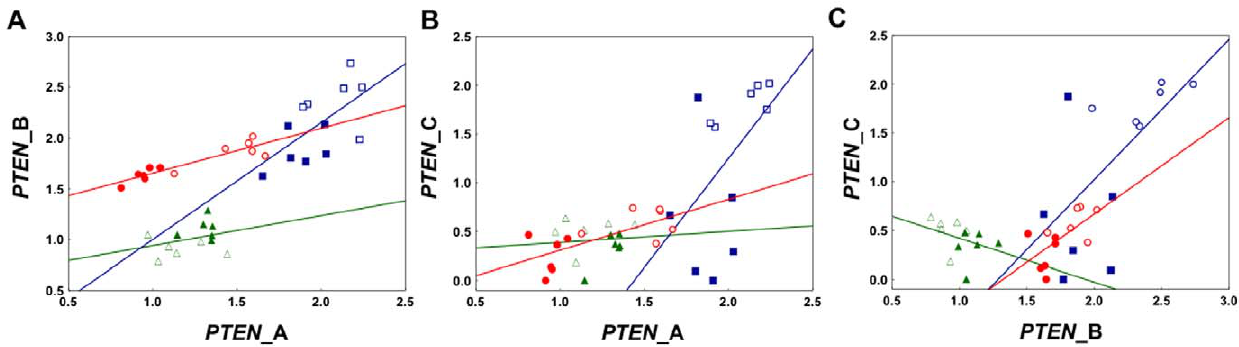
Figure 5. PTEN isoform-specific correlation plots by tissue. (A) Isoforms A and B, (B) Isoforms A and C (C) Isoforms B and C. Relative levels in brain (red circles), ovary (blue squares) and fat body (green triangles) are shown. Open circles, squares and triangles represent the forager data points while the closed symbols represent the nurse bee data points. As a general pattern, expression of PTEN isoforms is positively correlated in brain and ovary (Pearson’s correlation, p , 0.05), but not in the fat body of the workers (p .